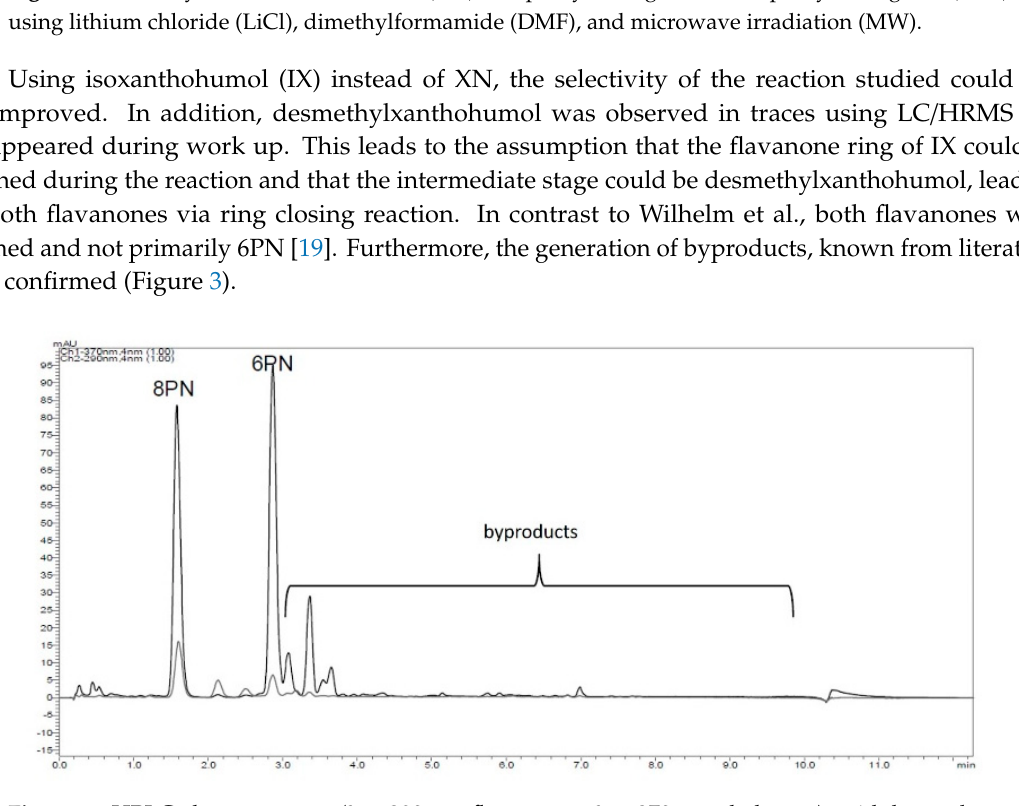
Figure 3. HPLC-chromatogram ( λ = 290 nm flavanones; λ = 370 nm chalcones), with byproducts resulting from the reaction of XN with LiCl in DMF using microwave irradiation.